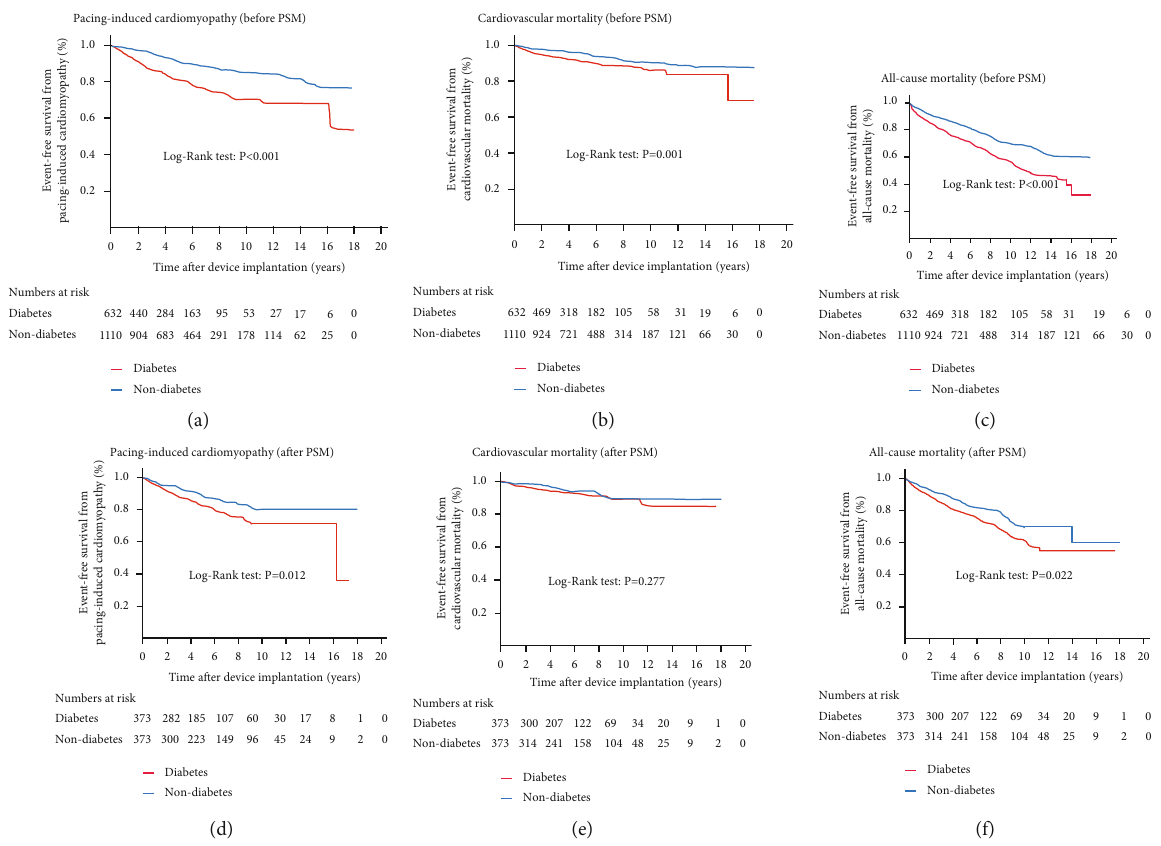
Figure 3: The Kaplan-Meier event-free survival curves of pacing-induced cardiomyopathy (a, d), cardiovascular mortality (b, e), and all- cause mortality (c, f) between the groups with and without diabetes before and after propensity score matching. PSM: propensity score